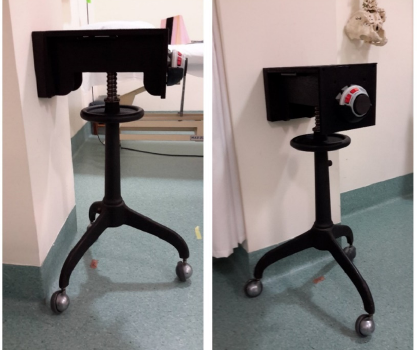
Figure 1. The height-adjustable stabilisation device with HHD inserted and the 3-wheel casters fixed to the floor. 2.4. Procedures Raters A and B measurements were taken independently on separate days, with re- peat testing occurring after 14 days. The raters had no contact during the assessments, and any residual markings on the patient’s skin were removed at the end of the testing. All measurements were taken bilaterally, and identical procedures were used for sessions 1 and 2. The measurement results were recorded on paper and stored on an excel spread- sheet by a third independent rater. All participants completed a simple, standardised warm-up procedure of general shoulder movements prior to assessment. The procedure started with shoulder forward flexion, using the identical protocol as Ginn et al. [12]. Reference points were identified using the following landmarks: the lateral epicondyle of the humerus, the point 6cm be- low the postero-lateral acromion process and the end of rib 12 (Figure 2). To ensure con- sistency and control for potential errors due to positioning, participants stood at a position marked by tape on the floor that was 1.5 metres away from the camera. The backdrop was a plain white wall with no decorations. The participant was instructed to move the upper extremity (thumb pointing upwards) to the end of active shoulder flexion within comfort levels. The assessor used the tablet device to photograph each end-of-range position from a perspective aligned with the axis joint of motion. The digital photograph was taken of the patient in profile, with the camera lens positioned parallel to the sagittal plane at eye level. All images were saved in JPEG format (1836 × 3264 pixels). A standardised, full- print A4 size (21 cm × 29.7 cm) colour photo was printed for each participant. Using a plastic goniometer and the printed photograph, the assessor manually calculated the re- sultant joint angle in degrees.